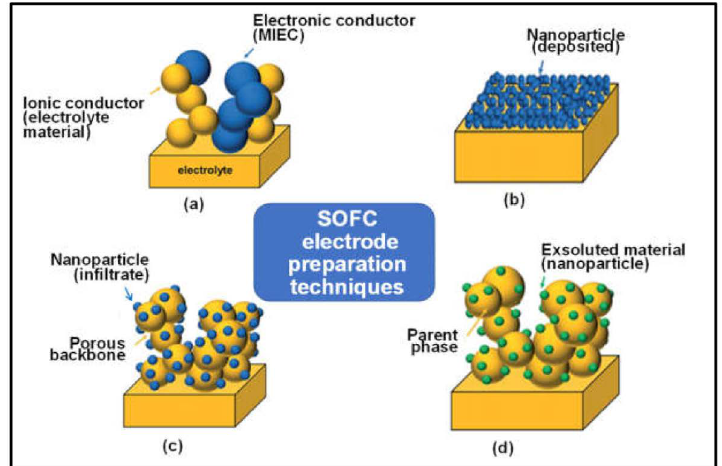
Figure 18. Schematic of various methods adopted for the fabrication of composite electrode us- ing ( a ) the conventional ceramic processing method, ( b ) thin-film deposition, ( c ) infiltration, and ( d ) ex-solution (adapted from